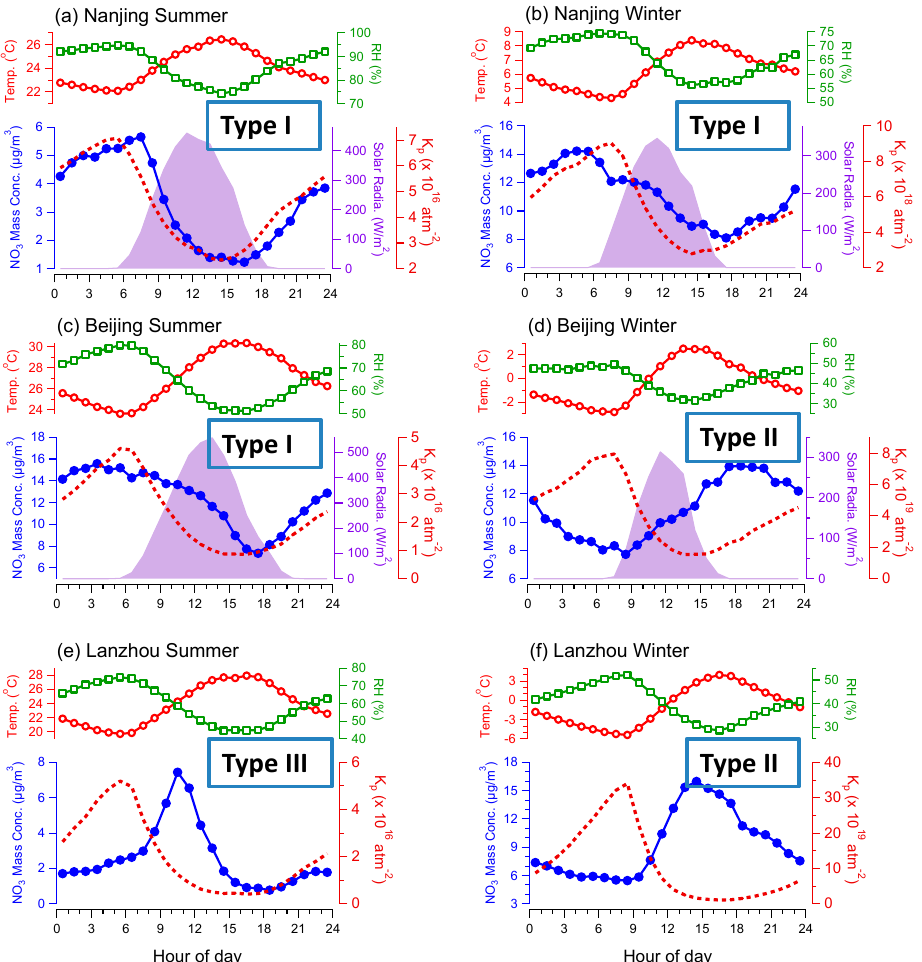
Figure 3. Diurnal patterns of temperature (top panel, left y axis), relative humidity (RH) (top panel, right y axis), nitrate concentration (bottom panel, left y axis), solar radiation and equilibrium constant ( K p ) of ammonium nitrate (bottom panel, right y axis) (K p = K p ( 298 ) exp for reaction NH 4 NO 3 (p) ↔ NH 3 (g) + HNO 3 (g). K p (298) is the equilibrium constant at 298 K (3.36 × 10 16 atm − 2 ), a = 75.11 and b = − 13.5 [16]): ( a ) Nanjing summer, ( b ) Nanjing winter, ( c ) Beijing summer, ( d ) Beijing winter, ( e ) Lanzhou summer, and ( f ) Lanzhou winter. (Type I—